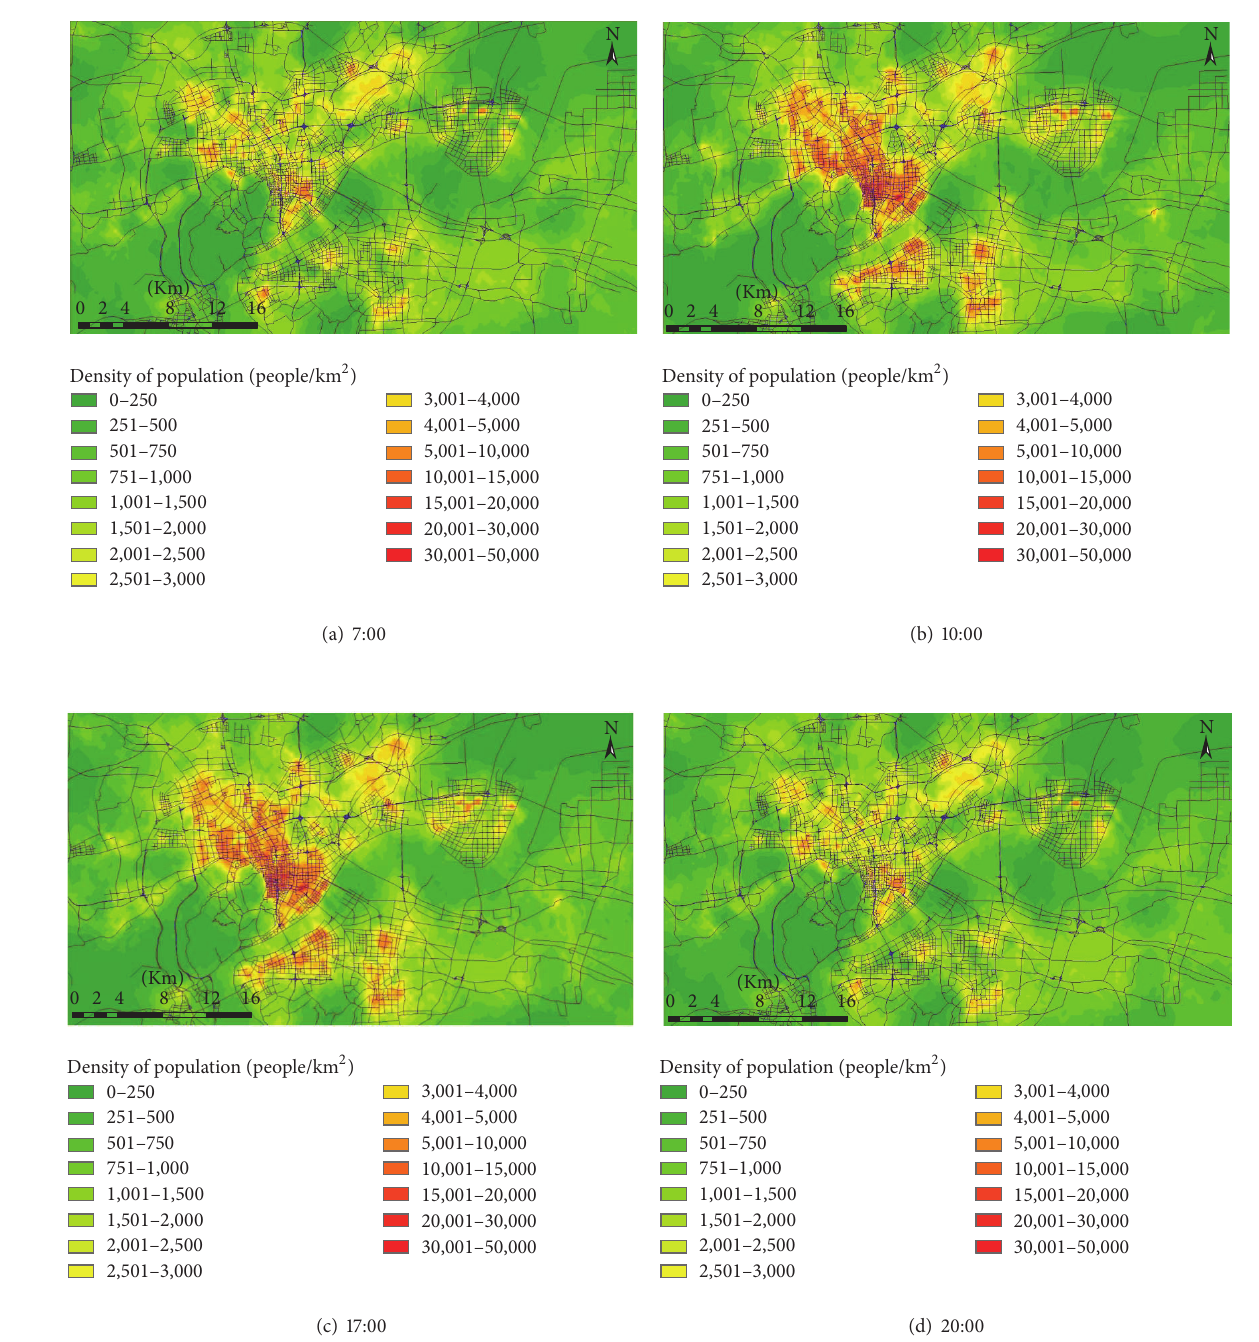
Figure 6: Spatiotemporal distributions of population density using mobile phone signaling data (September 8, 2015).